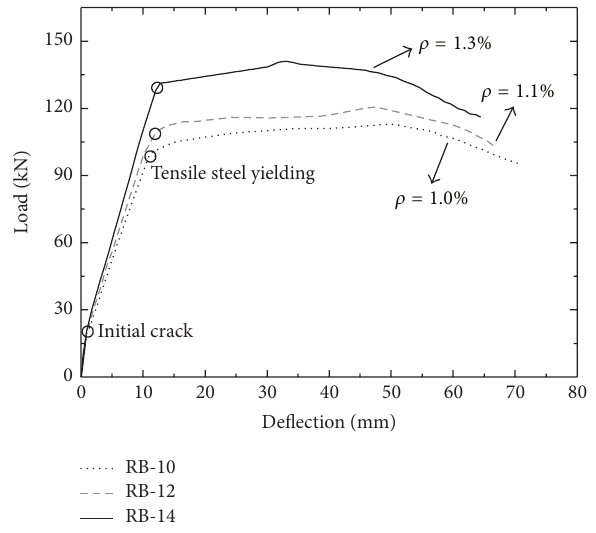
Figure 5: Deflection curves of the solid